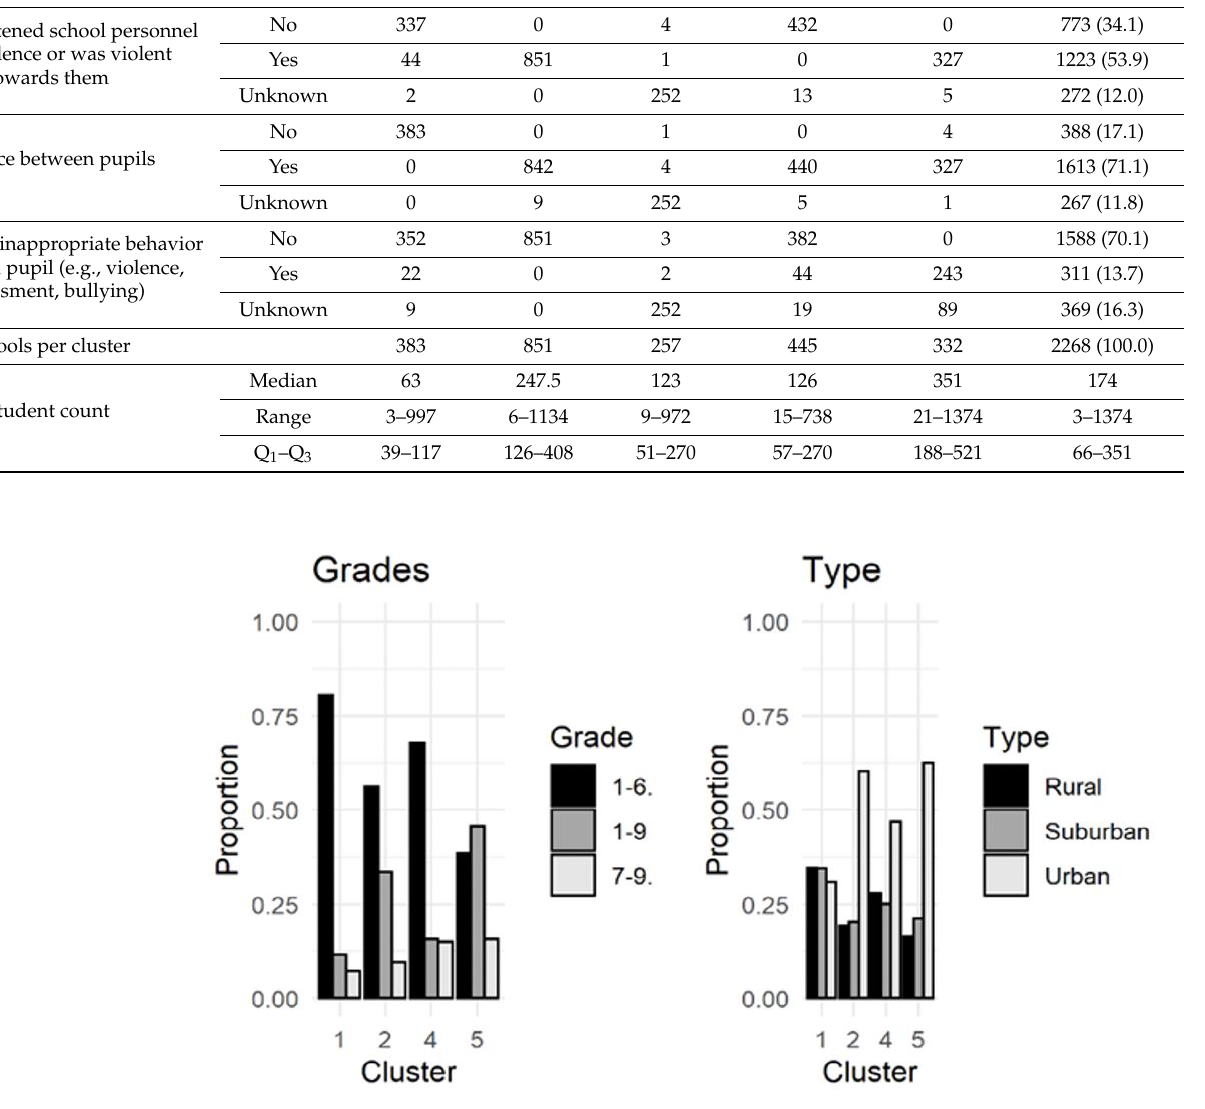
Figure 2. Proportion of type of school and municipality within clusters ( n = 2268). The heatmap in Table 2 indicates odds ratios for the pairwise comparisons, including variables with high enough effects size in our preliminary analysis (Cohen’s w > 0.2 or eta squared > 0.06). The columns of the heatmap represent cluster pairs, each row is one pairwise comparison of different variables. For example, the first row, first column estimates whether there are higher odds that the school in question is in cluster 2 than cluster 1 if the school’s type of municipality is rural compared to urban. If OR > 1 then the odds are higher for cluster 2, given the rural municipality compared to rural municipality. If OR < 1 odds are higher for cluster 1, given the rural municipality compared to rural municipality. The pairwise comparisons revealed that both management and monitoring as health promotion actions were related to higher incidence of school violence, whereas other actions, such as commitment, resources, common practices, and participation did